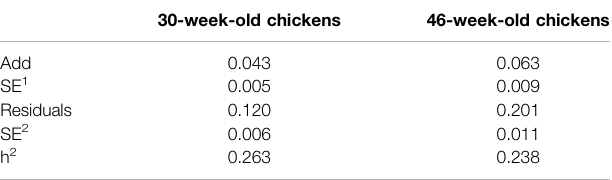
TABLE 2 | The genetic parameters of KB.